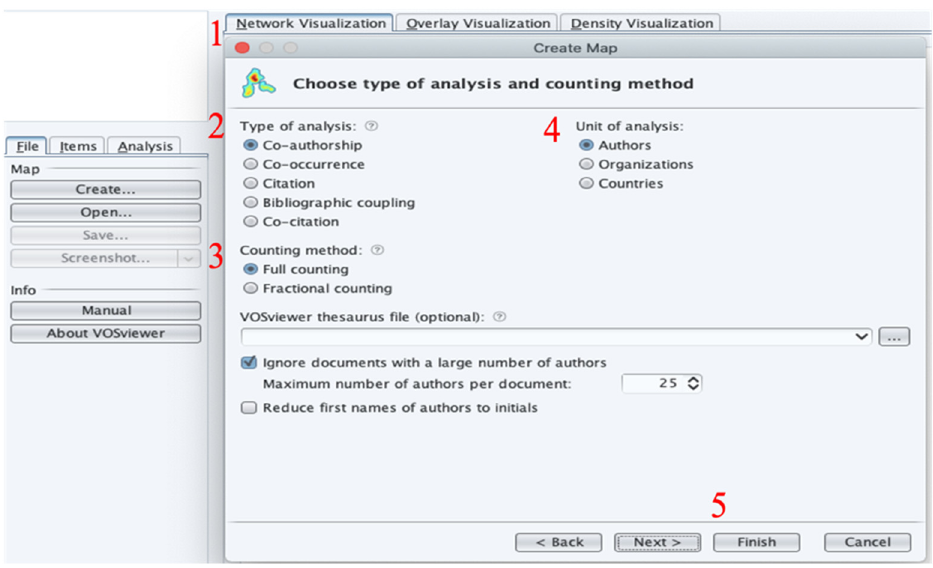
Figure 2. VOSviewer science-mapping workflow.